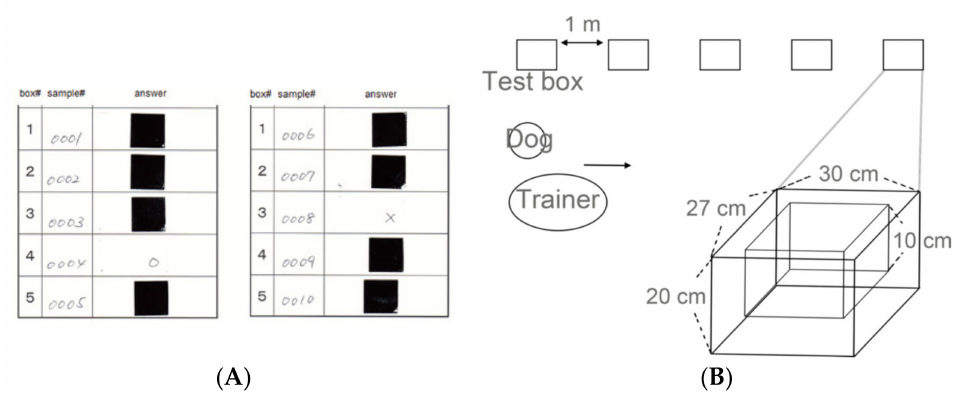
Figure 2. Test design. ( A ) The answer sheets used in the test. The test sample numbers and box numbers were shown on the answer sheet. The box number for the cancer sample was identified by an adjacent circle, and box numbers for the other samples were marked with an adjacent cross. The marks were then covered by a non-reattachable sticker. ( B ) The test boxes are wooden, storage containers 27 × 30 × 20 cm in size. Each box is equipped with a 10-cm deep wall inside to hold either a breath sample bag or a urine sample tube. The five test boxes were placed in a straight line on the floor at a distance of 1 m